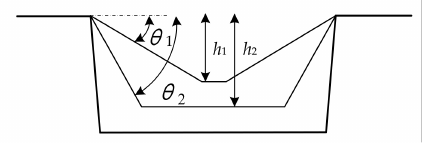
Figure 23. The traditional multistage forming strategy.